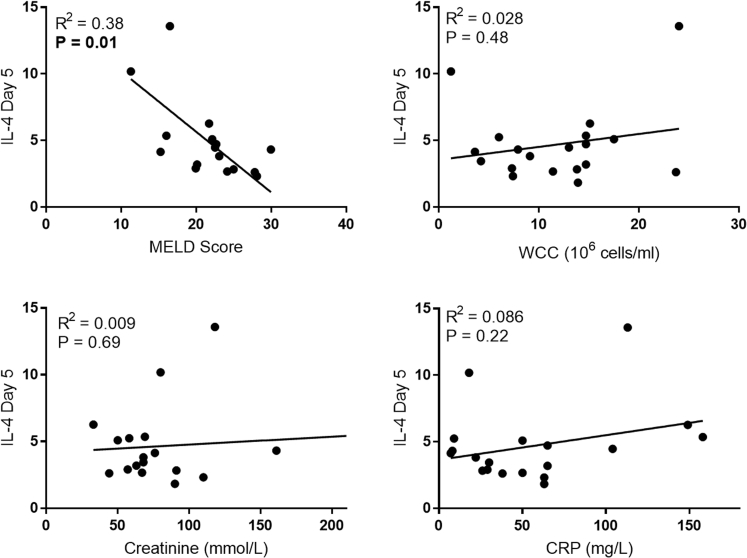
Day 5 plasma IL4 levels correlations with baseline clinical characteristics. Data represent product of Pearson correlation coefficient (n = 13–16). Best-fit linear slope is also included. CRP, C-reactive protein; IL, interleukin; MELD, Model for End-Stage Liver Disease; WCC, white cell count.